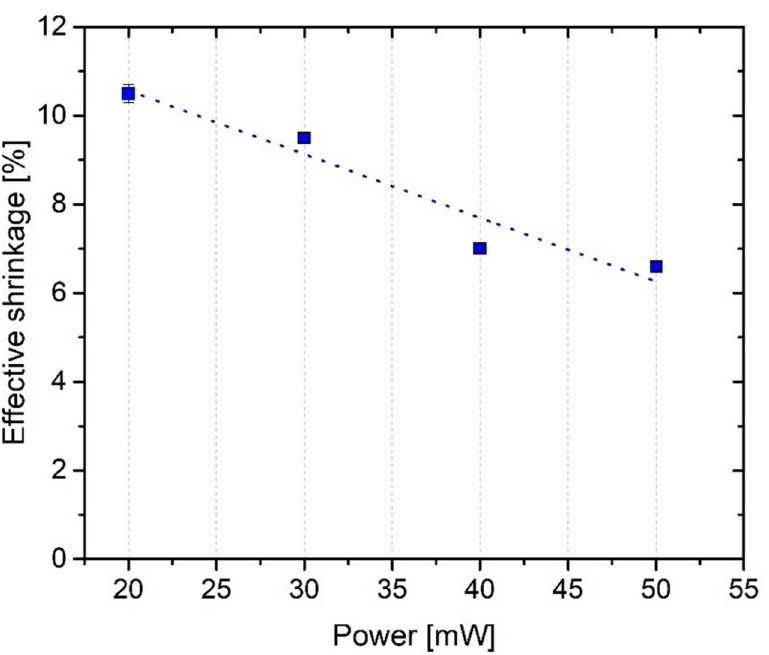
Figure 9. Effective shrinkage of cuboids in ACM 2:8 dependent on the applied laser power reveals the occurrence of a non-constant shrinkage behavior. The dotted line is a guide-to-the-eye.